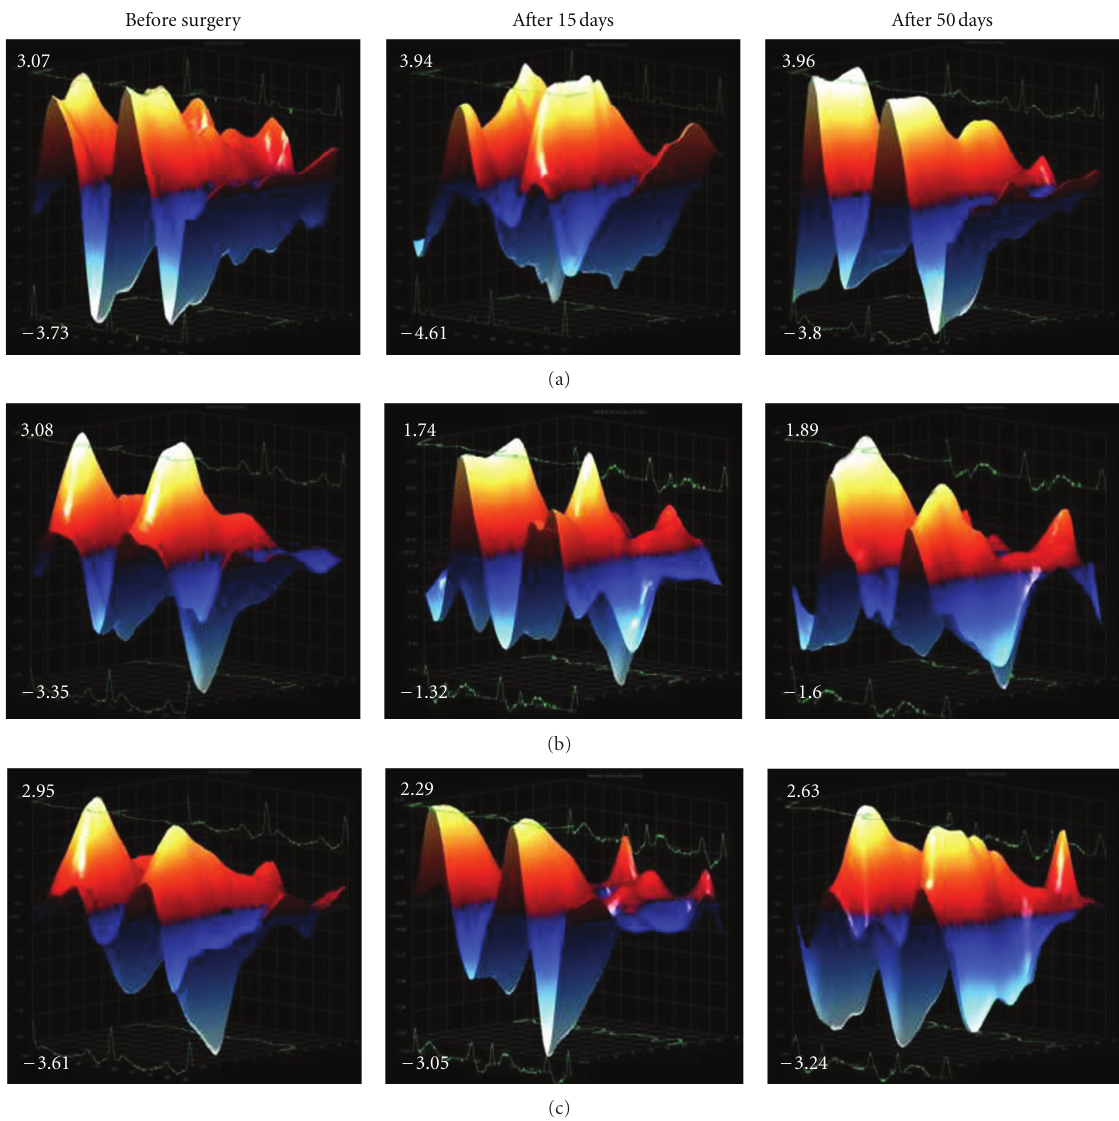
Figure 4: Representative images of the radial strain analysis of the velocity (cm/s) at basal conditions and after 15 and 50 days of MI. (a) sham group, (b) MI group, and (c) MI + HP β CD/Ang-(1–7).